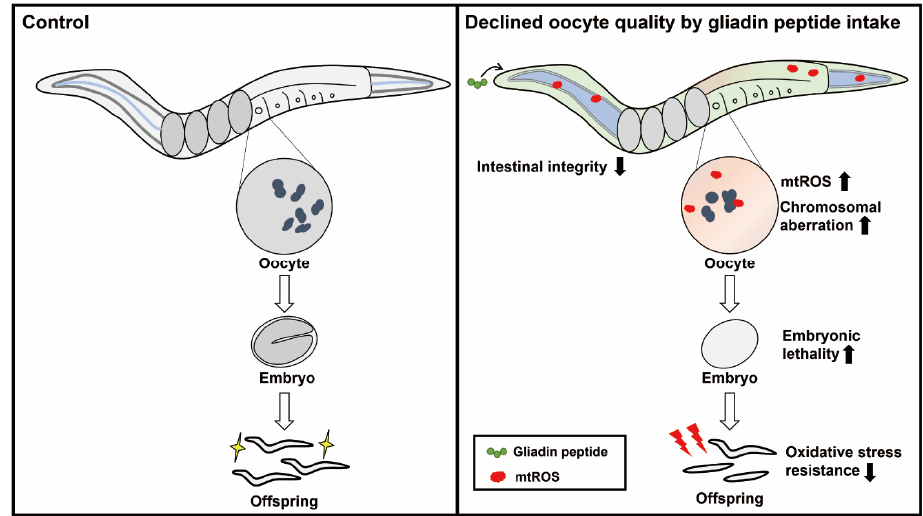
Figure 6. Working model: maternal gliadin peptide (GP) intake in day-3 adult C. elegans increases the level of mitochondrial ROS (mtROS) and decreases oocyte quality with chromosomal aberrations, consequently increasing embryonic lethality and decreasing oxidative stress resistance in offspring.